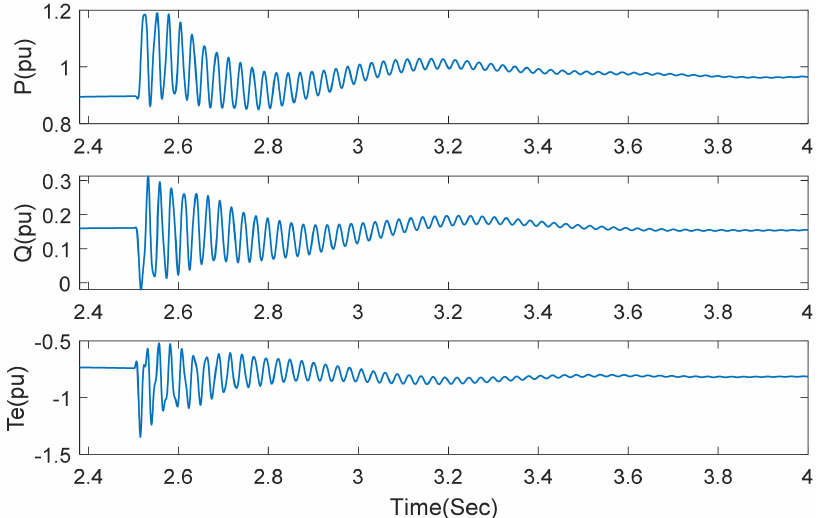
Figure 5. Transient responses of active power, reactive power, and electromagnetic torque after 85% series compensation is switched.